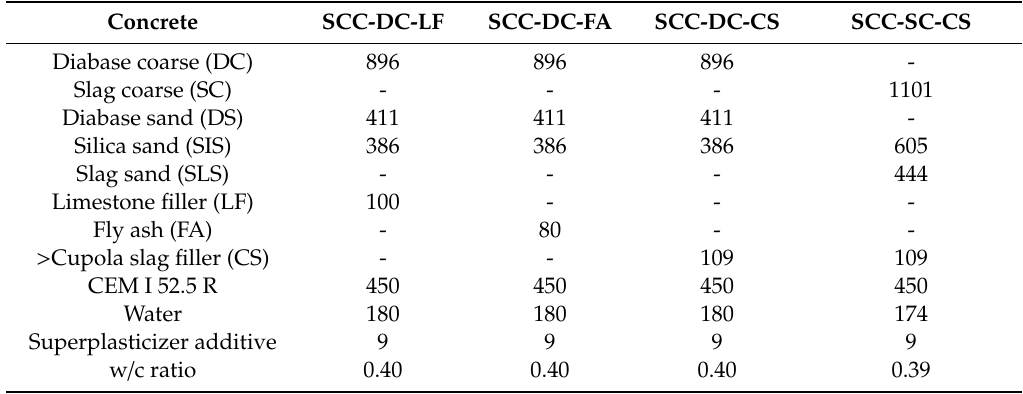
Table 5. Concrete mix proportions (kg / m 3